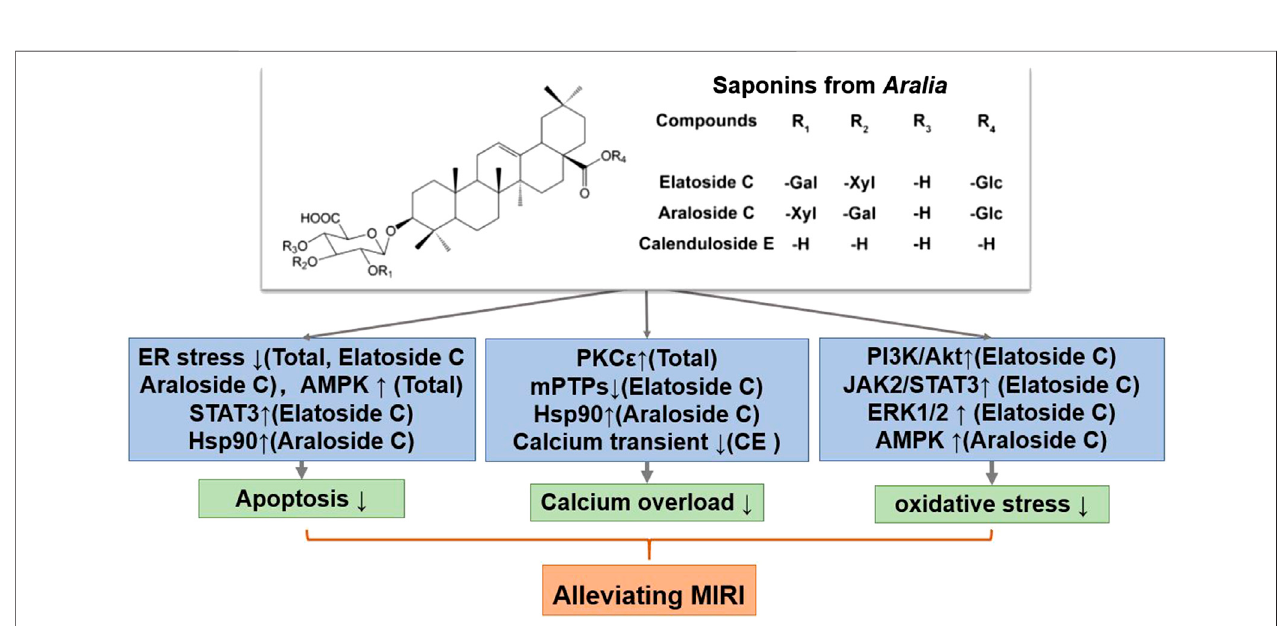
FIGURE 3 | A schematic representation of mechanisms of saponins from Aralia exerted cardioprotective effects in MIRI. Glc, glucose; Gal, galactose; Xyl, xylopyranose. ↑ means activate relevant pathways. ↓ means suppress relevant pathways.